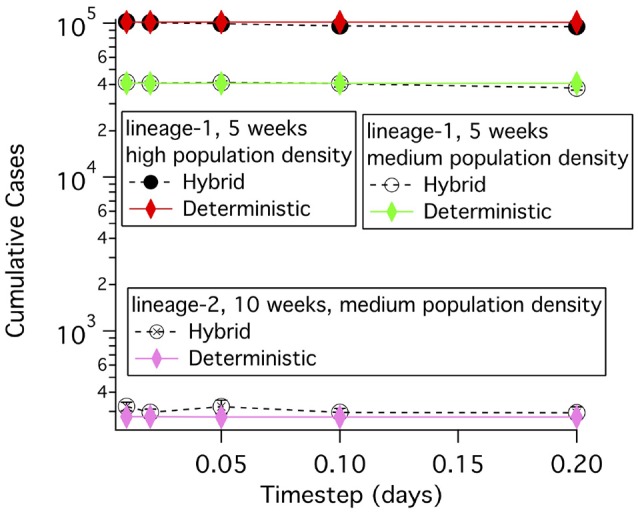
Cumulative case counts at simulation ends vs. the time step used in the simulation for both deterministic and hybrid simulations. For the hybrid model, the mean and standard deviation of 5 simulations each averaging 30 runs of the model are shown.